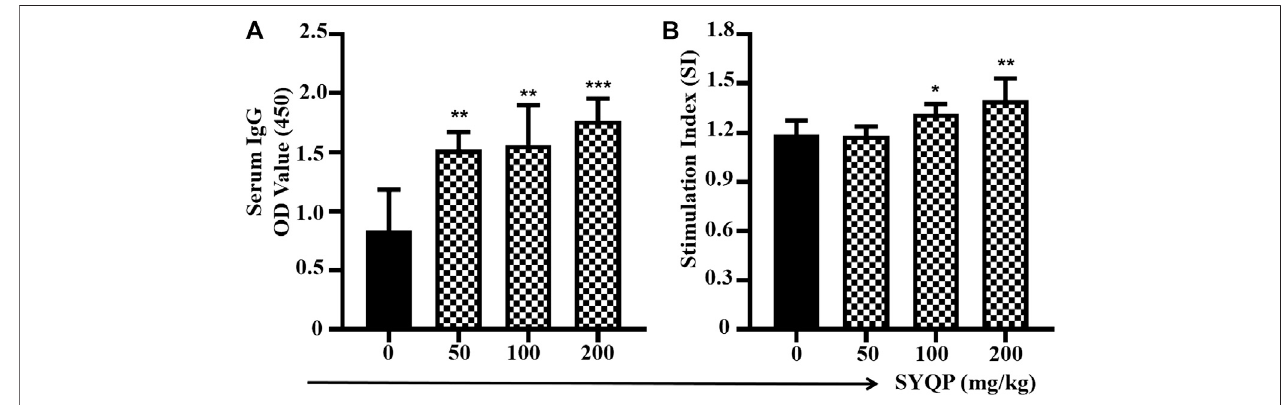
FIGURE 6 | SYQP enhanced antigen-speci fi c immune responses in OVA-immunized mice models. C57BL/6 mice were subcutaneously immunized with OVA (100 µg) at weeks 0 and 3. SYQP was given at 50, 100, and 200 mg/kg by intragastric administration once a day for four consecutive days before each immunization. Twoweeks after the second immunization, blood samples were collected for measurementofOVA-speci fi c IgG byELISA. Splenocytes were harvested and exposed to OVA100 μ g/mlagainfor48 htodetermineantigen-speci fi clymphocyteproliferationbyMTSassay.Stimulationindex (cid:2) (OD OVAexposure − Blank)/(OD OVAnon-exposure −